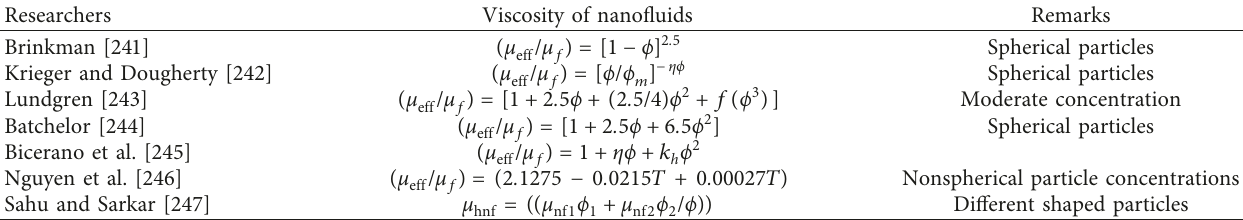
Table 6: Some of the models found in the literature.